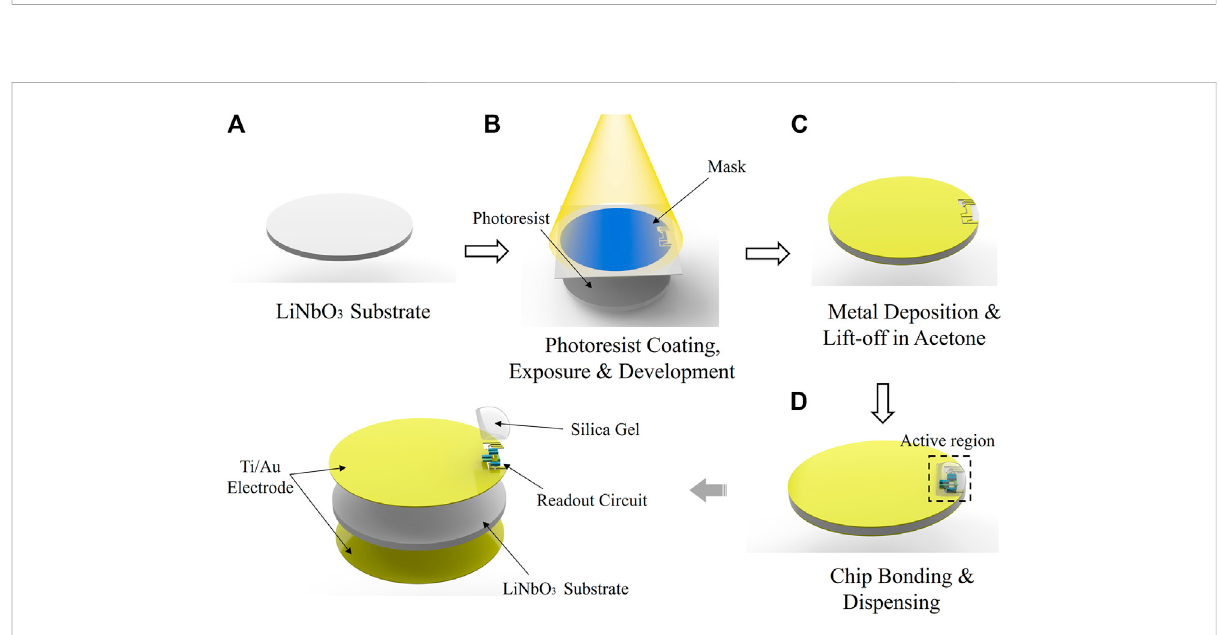
FIGURE 6 MethodforheterogeneousintegrationofpiezoelectricdevicesandSi-basedintegratedcircuits. (A) substratepreparing; (B) photoresistcoating, exposure and development; (C) metal deposition & lift-off in acetone; (D) chip bonding and